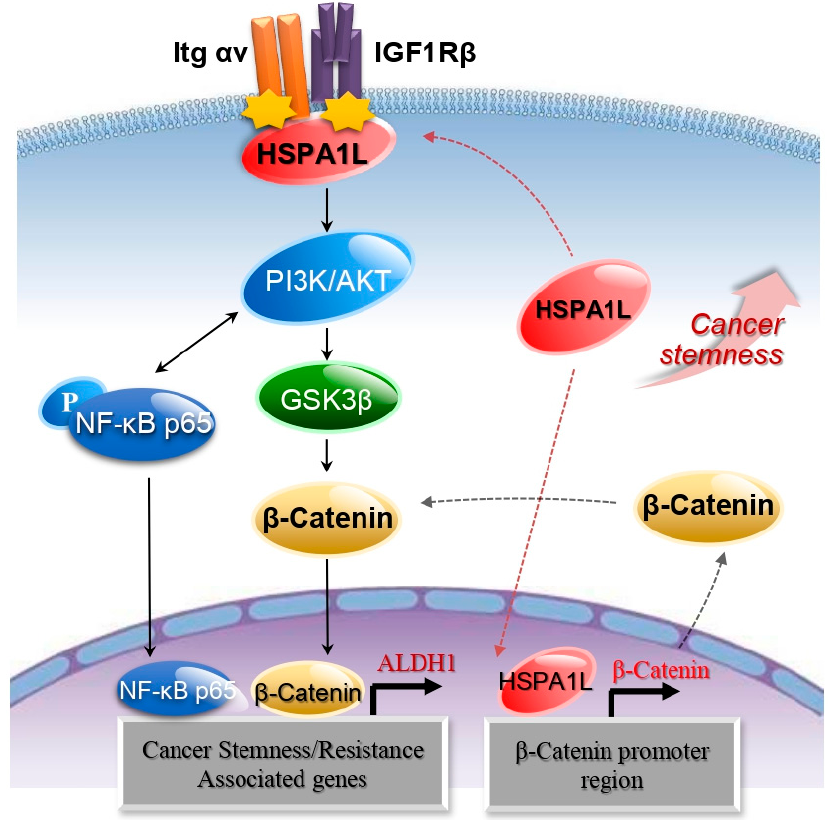
Figure 7. Schematic model for two-way functions of HSPA1L between the cytosol and nucleus. HSPA1L promoted EMT and tumorigenic capacity through β -catenin expression.